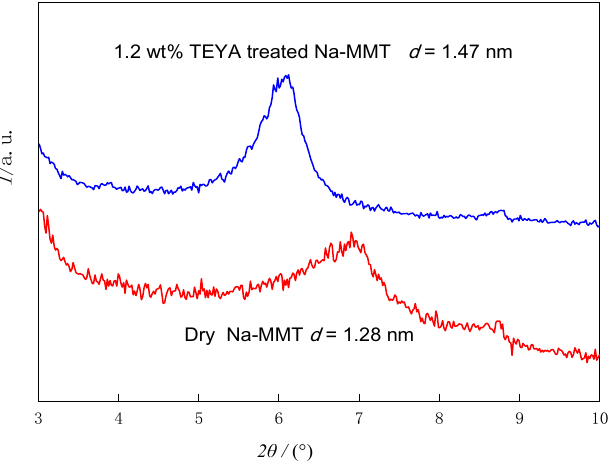
Figure 6. X-ray diffraction (XRD) of dry Na-MMT and TEYA/Na-MMT. The inhibition mechanism is shown in Figure 7. In the water environment, water